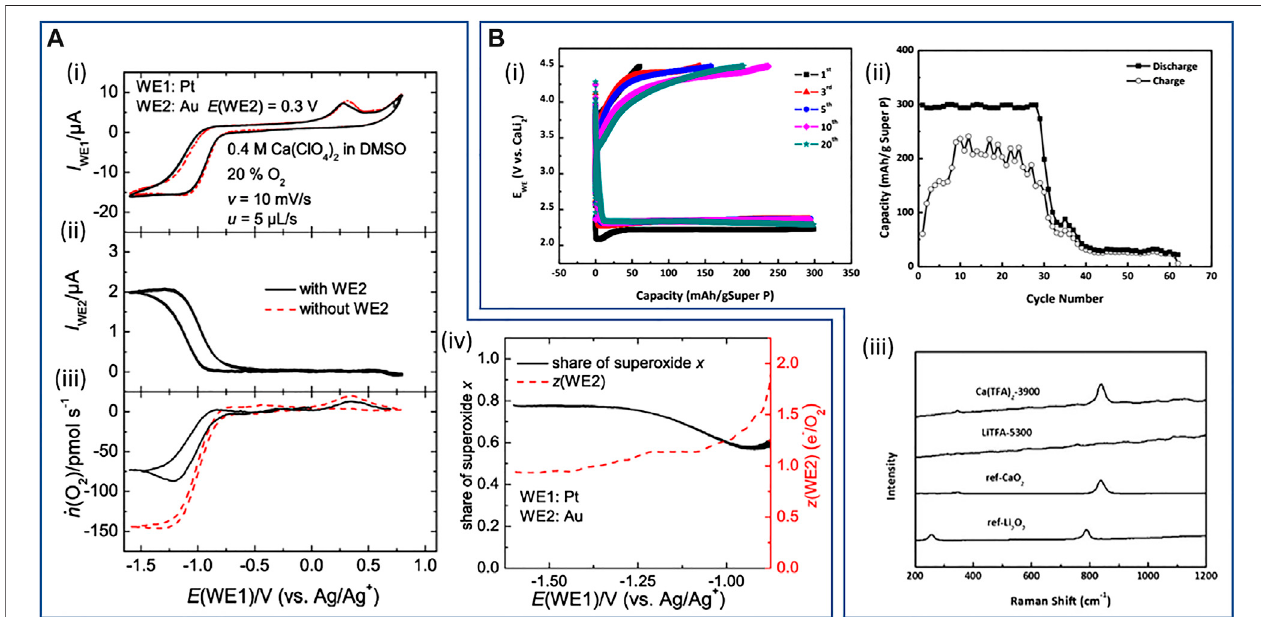
FIGURE 6 | (A) Identi fi cation of the soluble products via DEMS using 0.4 M Ca[ClO 4 ] 2 /DMSO saturated with a mixture of 80% Ar and 20% O: (i) cyclic voltammograms at the Pt-working electrode (WE) with (black) and without (red) the use of an Au-sputtered Te fl on membrane (E(WE2) (cid:2) 0.3 V) in the detection compartment. (ii) Faradaic currents at the sputtered Te fl on membrane. (iii) Corresponding fl ow of oxygen ṅ (O 2 ). (iv) Resulting electron numbers at the second working electrode (black) and share of superoxide x (red) calculated. (A) Reproduced with permission from (Reinsberg et al., 2016b). Copyright 2016 American Chemical Society. (B) Intermetallic CaLi 2 -O 2 batteries: (i) voltage pro fi le of galvanostatic cycling and (ii) capacity retention of CaLi 2 -O 2 cell using 0.1 M Ca[OTf] 2 /TEGDME at a current density of 50 mA g − 1 SuperP and acapacityof 300mAh g − 1 SuperP . (iii) Raman spectra ofthe fullydischarged cathodes without PVDF of CaLi 2 -O 2 cells where